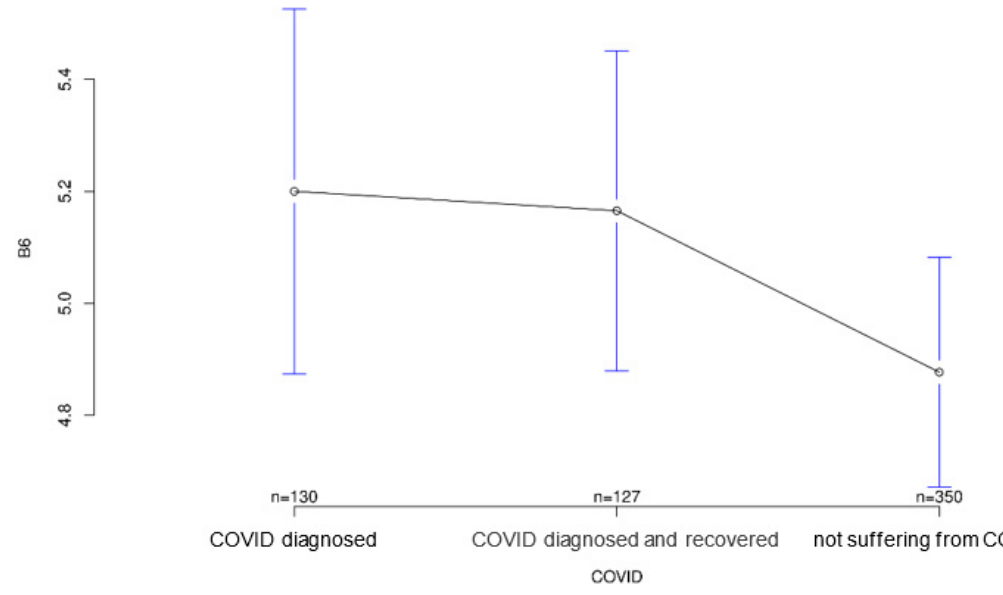
Figure 8. Average agreement with statement 6 of the COVID-specific questionnaire: “Thanks to new digital technologies,